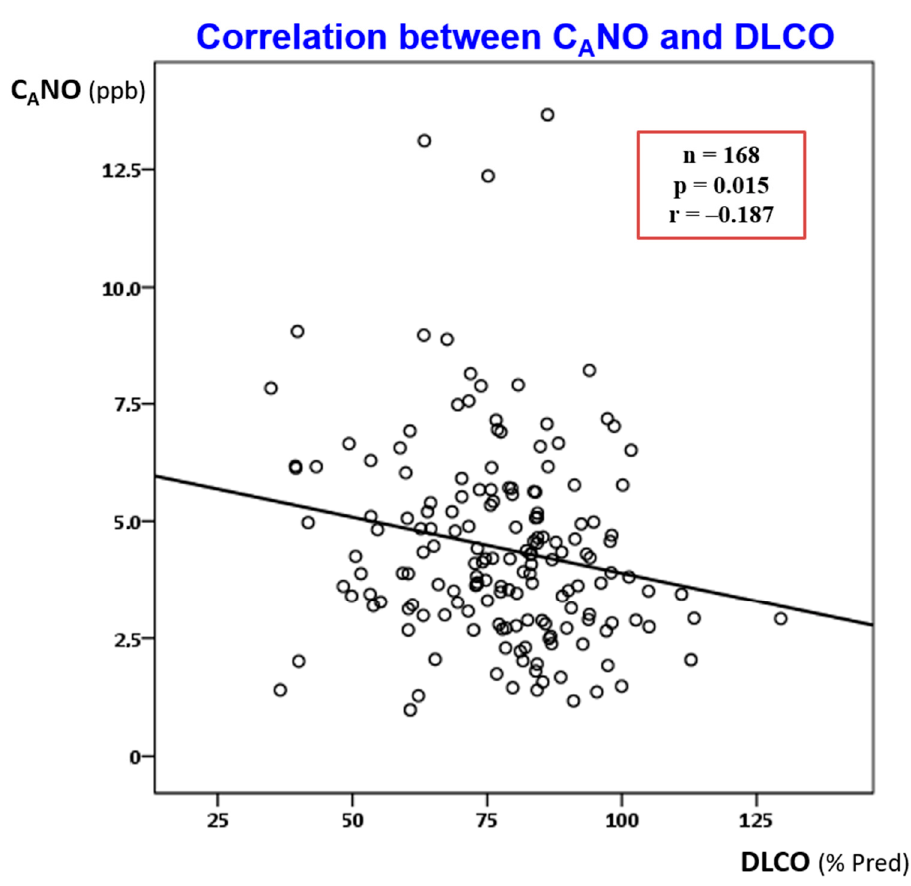
Figure 3. Correlations between alveolar concentration of exhaled nitric oxide (CaNO) and diffusion capacity of the lung for carbon monoxide (DLCO) in patients with recovered SARS-CoV-2 pneumonia. The correlation between the alveolar concentration of exhaled nitric oxide (CaNO) and the diffusion capacity of the lung for carbon monoxide (DLCO) in patients with recovered SARS-CoV-2 pneumonia was investigated using Pearson’s method, with p < 0.05 and a negative Pearson coefficient of correlation −